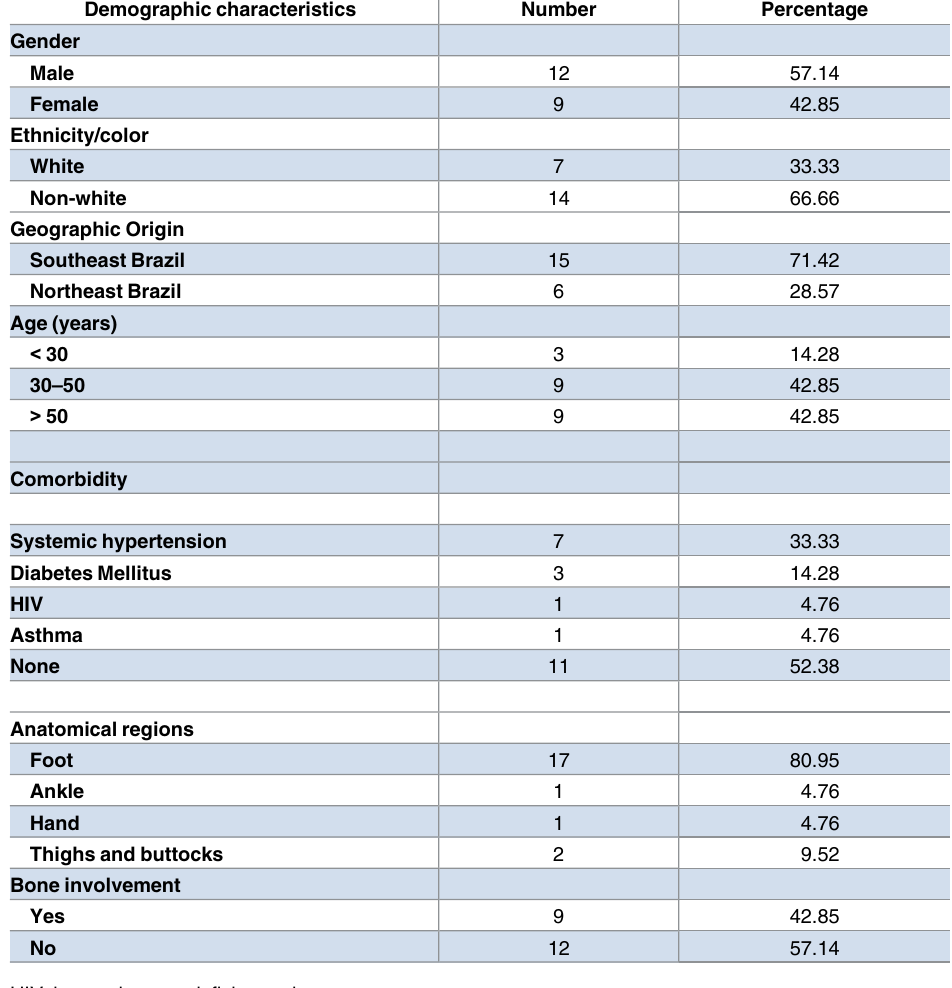
Table 1. Demographic, clinical and laboratorial characteristics of 21 patients diagnosed with myce- toma at the Evandro Chagas National Institute of Infectious Diseases,Oswaldo Cruz Foundation, Rio de Janeiro—Brazil, from 1991to